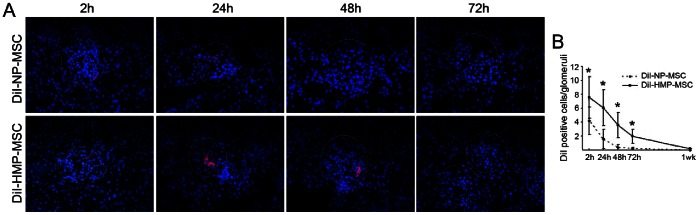
MSC detection in kidney by fluorescence microscopy.(A)MSC was labeled with CM-DiI and appeared red under fluorescent microscopy (nuclei stained blue with DAPI). The labeled cells were mainly detected in glomeruli (dashed circles) after injection. Magnification ×400. (B) CM-DiI labeled MSC was quantified by counting the number of red staining cells per glomeruli in 20 non-sequential sections under ×200 magnification. The number of MSC migrated to the kidney cortex was higher and the retention time was longer in HMP-MSC group than in NP-MSC group. *P<0.01, vs DiI-NP-MSC.